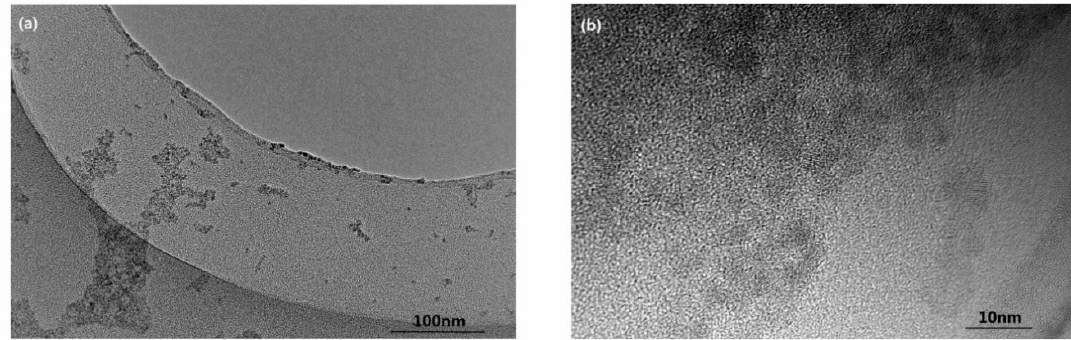
Figure 1. High-resolution transmission electron microscope (HRTEM) image of CdSe QDs: ( a ) 97,000×, 200 kV. ( b ) 690,000×, 200 kV. Table 1. Fitting parameters of the fluorescence decay curve.